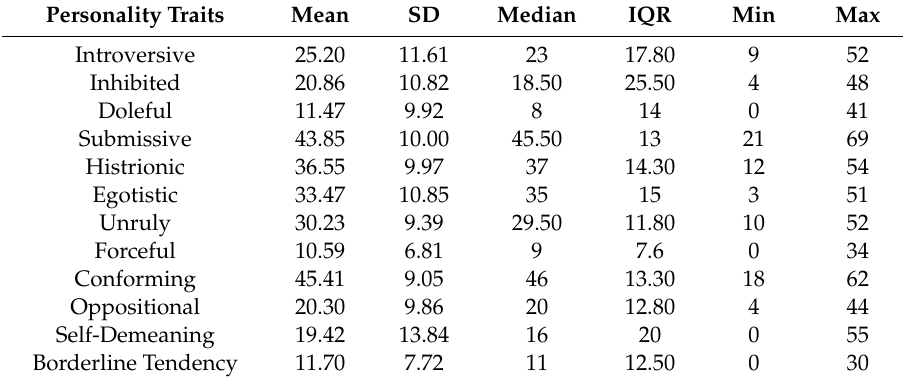
Table 1. Descriptive statistics of the personality traits of the Millon Adolescent Personality Inventory (MACI) scale ( n = 66).